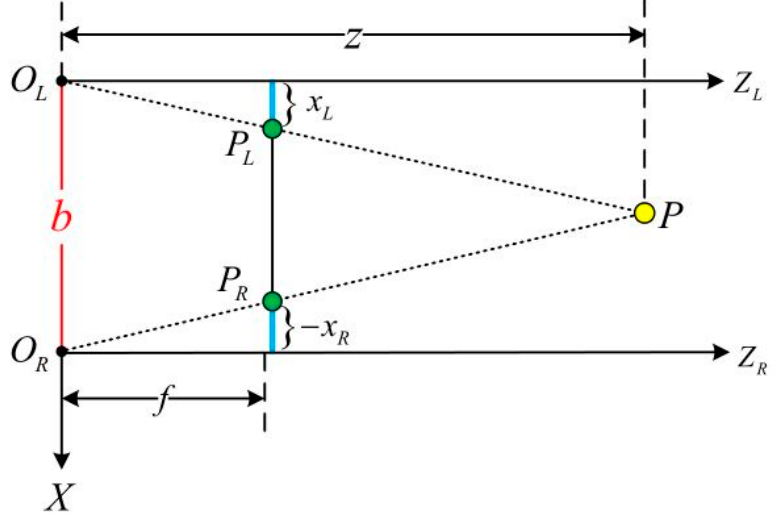
Figure 3. Binocular camera depth calculation schematic.